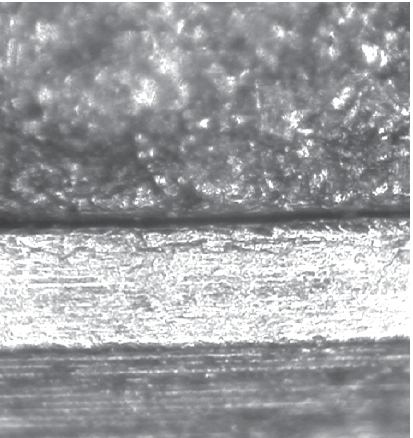
FIGURE 4- Graphic presentation of mean marginal misfit for each force used. Columns with the same letter do not differ one from the other at 5% level of significance (Tukey